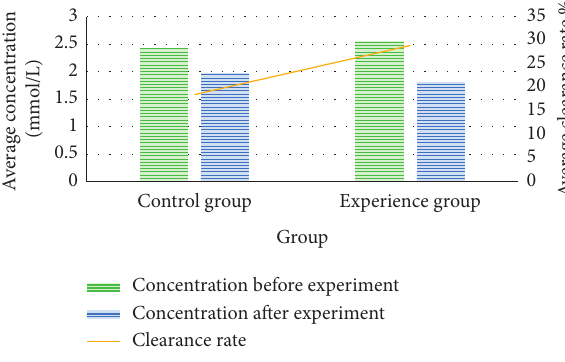
Figure 2: Analysis of clearance effect of P